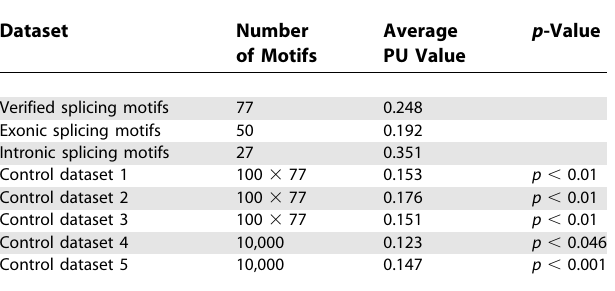
Table 1. Comparison of Average PU Values for Verified Splicing Motifs and All Control